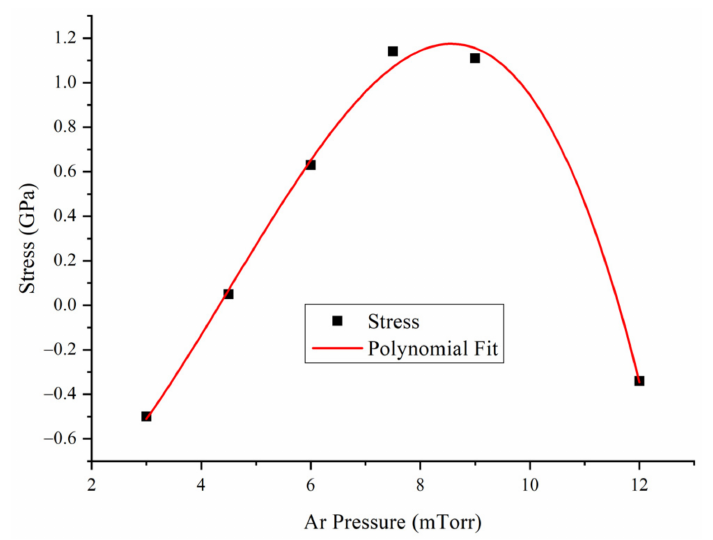
Figure 4. The stress of Nb films versus Ar